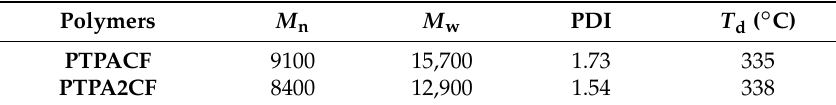
Table 1. Molecular weights and thermal stability for the polymers.